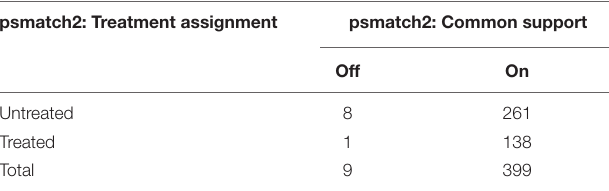
TABLE 4 | Propensity score variable matching.